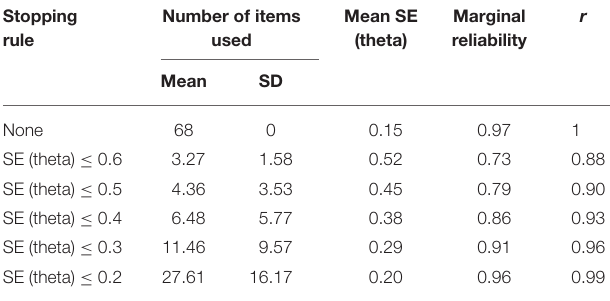
TABLE 5 | Characteristics of the CAT-Depression under several stopping